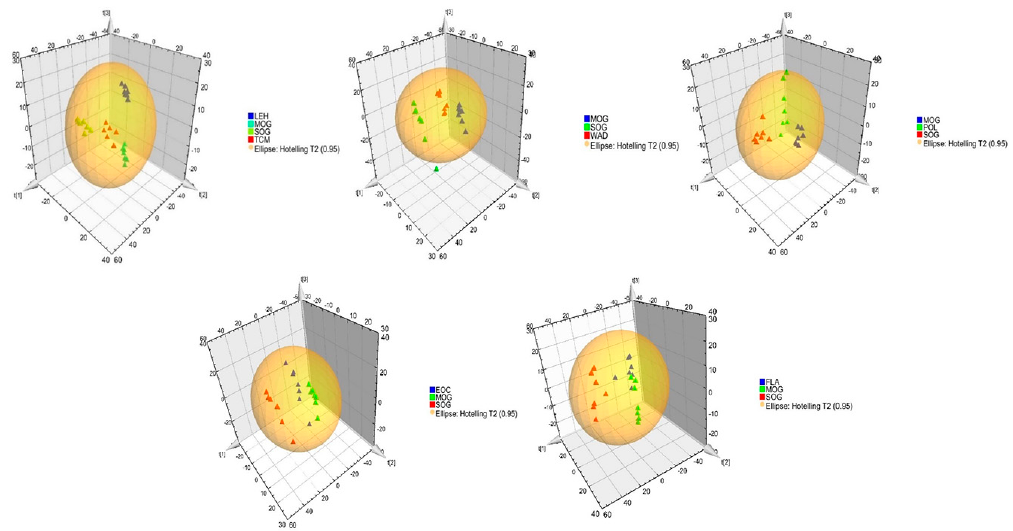
Figure 4. 3D PLS-DA score plot in positive ion mode. Notes: Sham-operated group (SOG), Chronic nonbacterial prostatitis model group (MOG), Water decoction treatment group (WAD), Essential oil treatment group (EOC), Polysaccharide treatment group (POL), Flavonoids treatment group (FLA), Pule’an tablet treatment group (TCM), Levofloxacin treatment group (LEH).